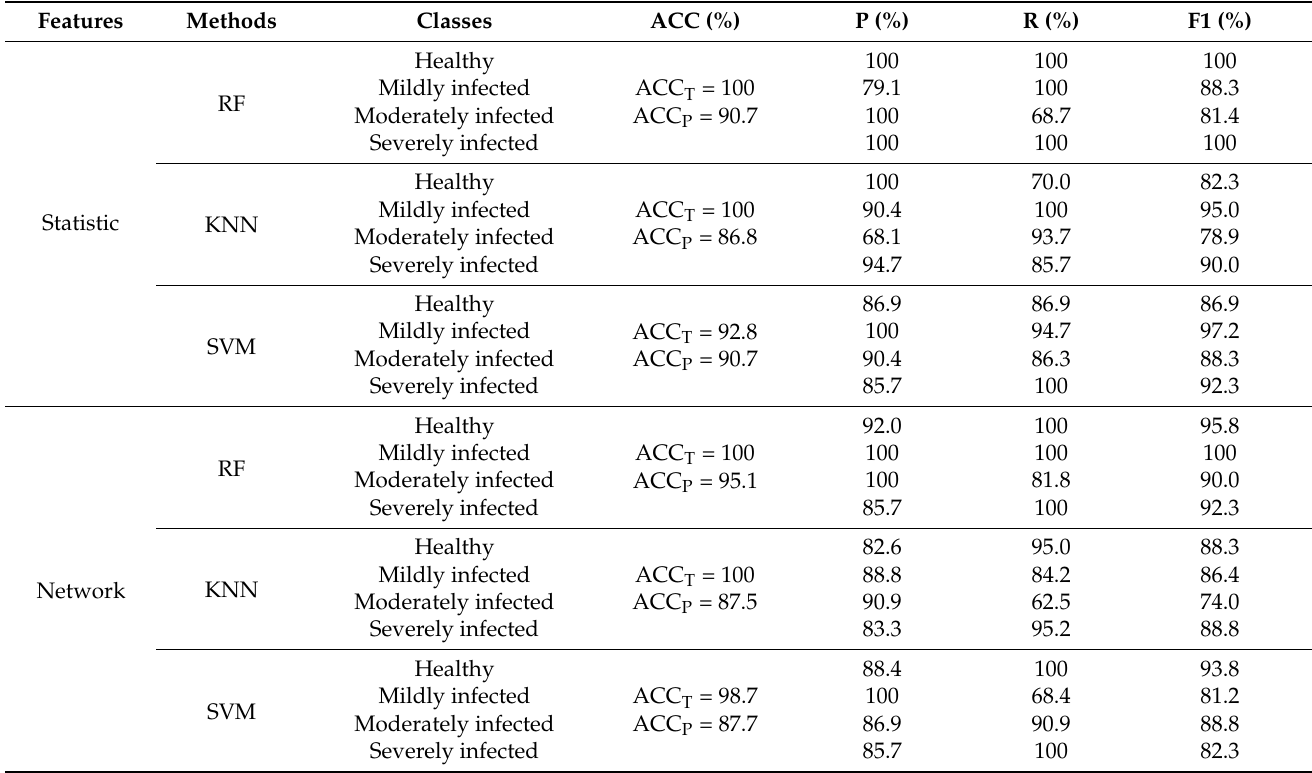
Table 1. Classification results of BRM infection degree in apples using RF, KNN, and SVM with